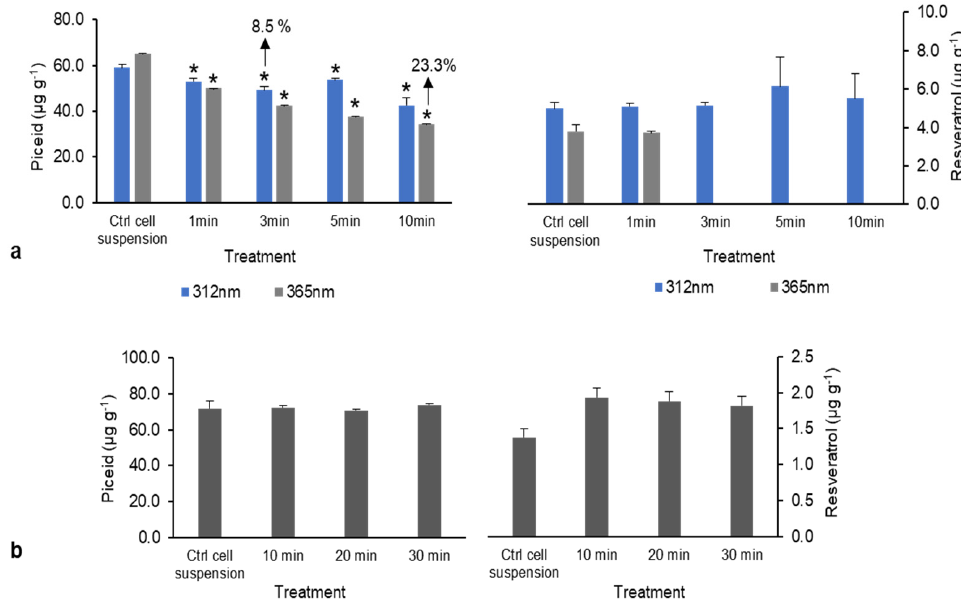
Figure 3. Piceid and resveratrol content following physical treatment. ( a ) UV radiation (UV-B at 312 nm and UV-A at 365 nm). ( b ) Sonication (10, 20, and 30 min). * Denotes significant differences at p < 0.05) between treatment and control groups.